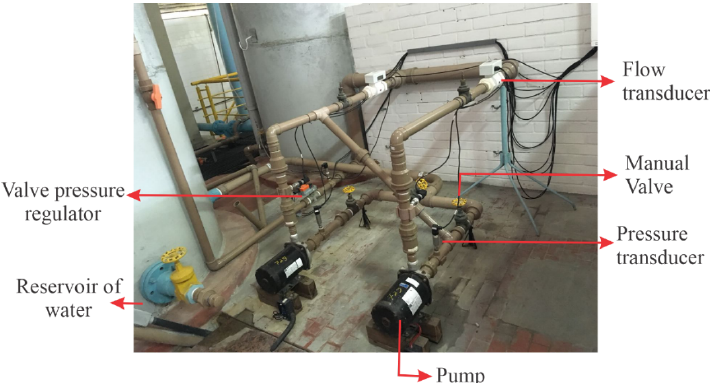
Figure 10. Experimental setup for data acquisition.